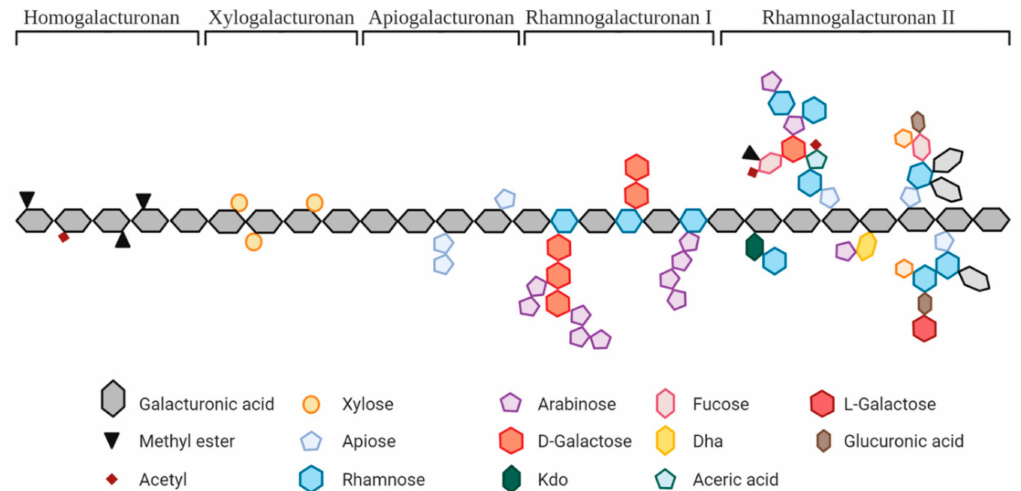
Figure 1. Overview of the pectin structure [3]. Copyright: Creative Commons—Attribution 4.0 International—CC BY